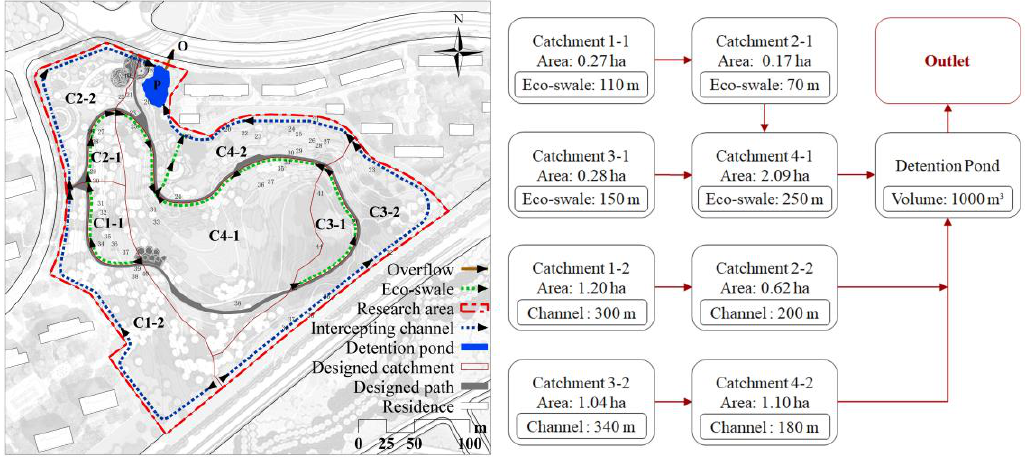
Figure 6. Facilities layout and design workflow diagram for S2.